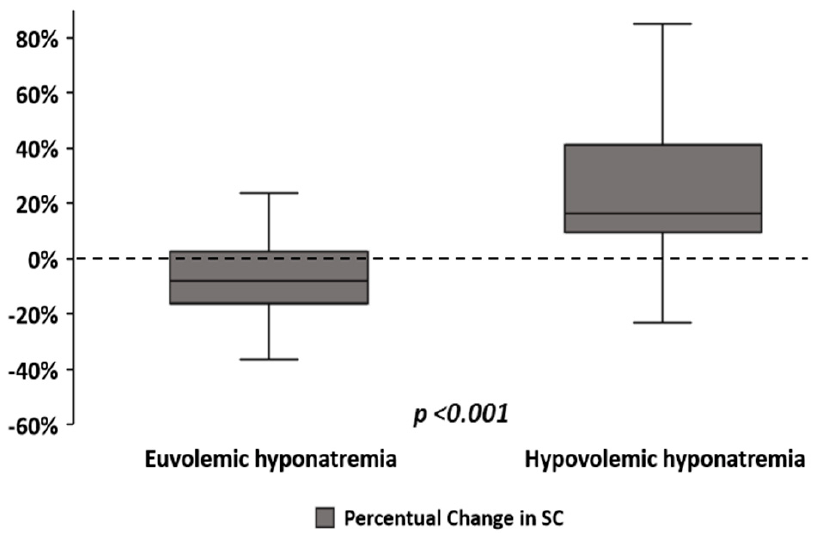
Figure 2. Median of ∆ SC% from eunatremia to hyponatremia, classified according to volemic status during hyponatremia. SC: serum creatinine. ROC curves for ∆ SC and ∆ SC% are displayed in Figure 3. In the entire group, ROC curve analysis found an AUC of 0.918 (95%CI: 0.865 to 0.970, p < 0.001) for ∆ SC, and an 0.908 (95%CI: 0.853 to 0.962, p < 0.001) for ∆ SC%, to differentiate HH from EH. The calculated OR, sensitivity, specificity, PPV and NPV of the optimal cut-off points of SC and ∆ SC% to classify patients as hypovolemic or euvolemic, are shown in the Table